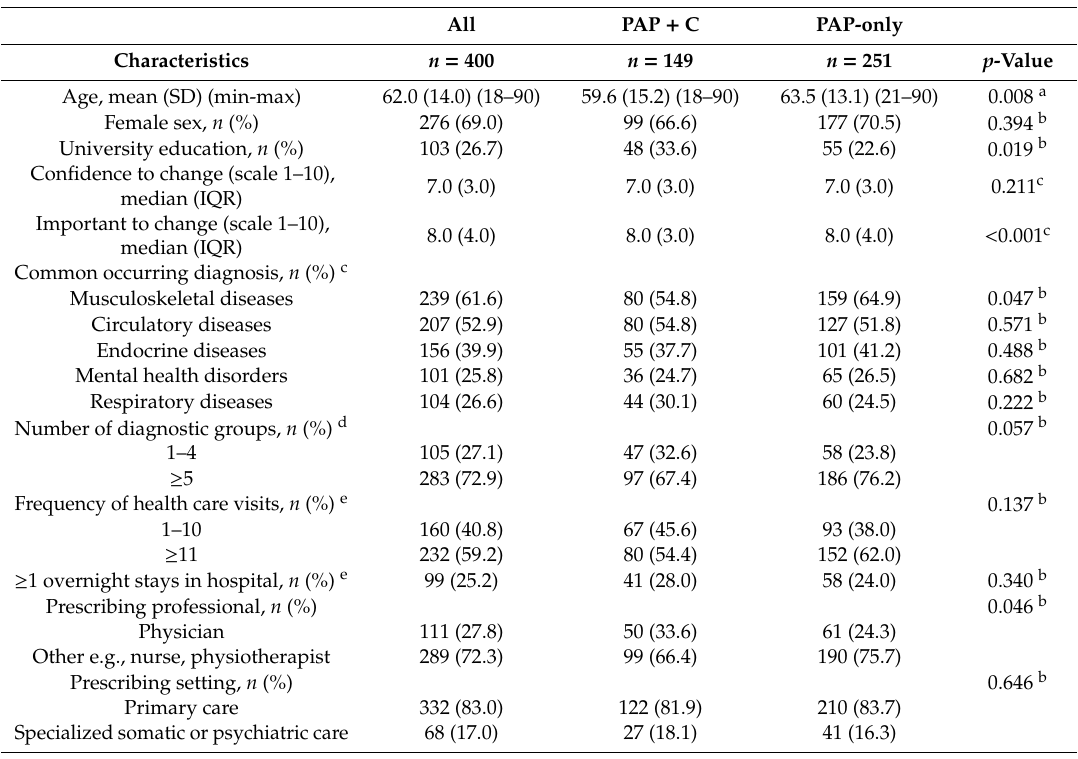
Table 1. Characteristics in all participants at baseline and di ff erences in characteristics between the study